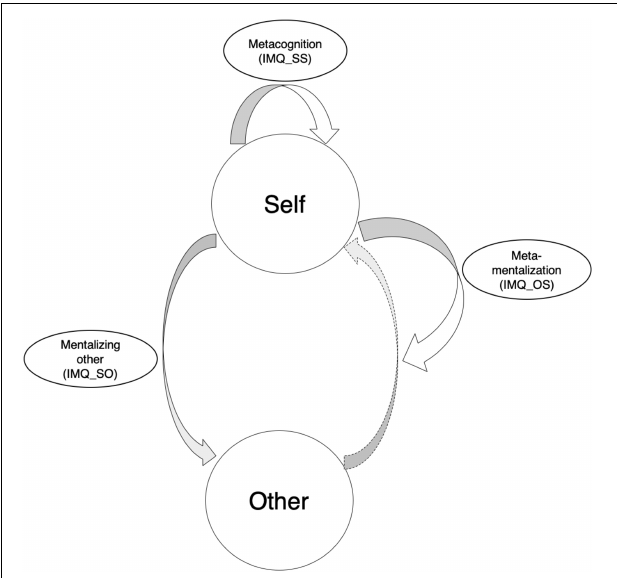
FIGURE 1 | The three different components (IMQ_SS: self–self mentalization; IMQ_SO: self–other mentalization, and IMQ_OS: other–self mentalization) in our Interactive Mentalization